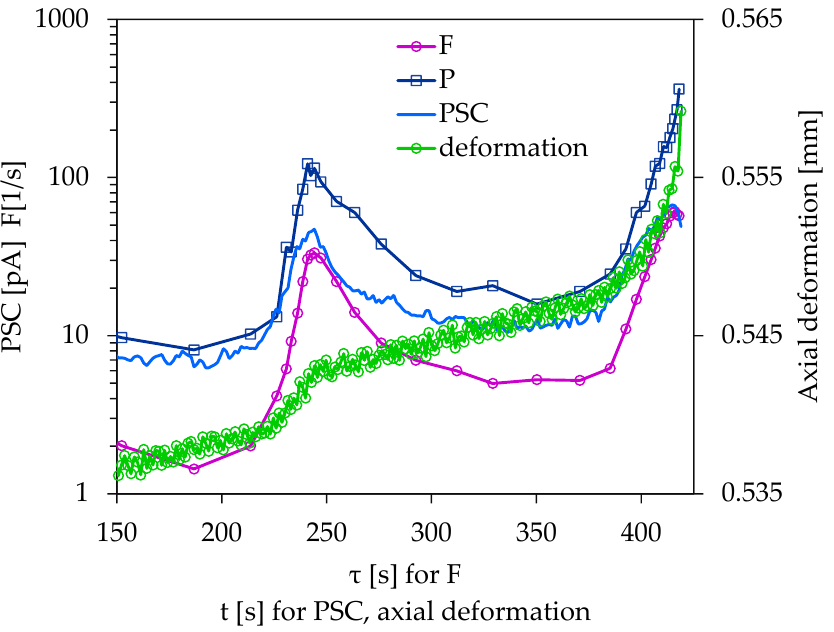
Figure 7. Temporal evolution of the F - function and the PSC in juxtaposition with the axial mechanical deformation, during the stay of the specimen under a constant load regime until fracture.